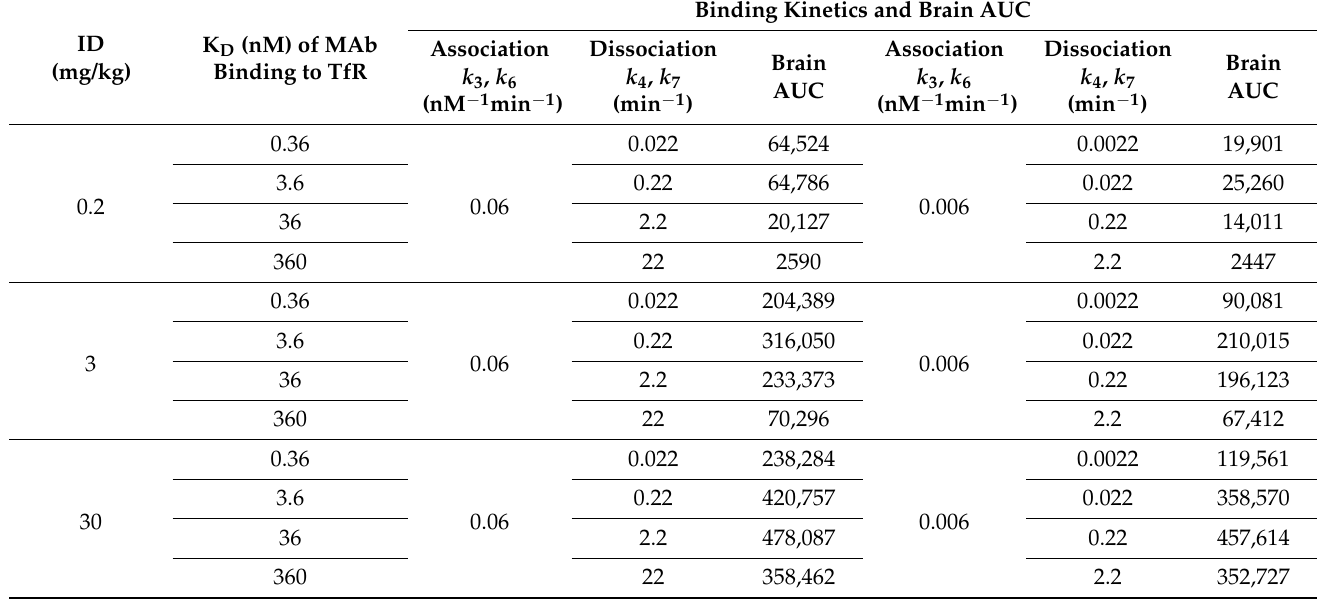
Table 4. TfRMAb K D , binding kinetics, and brain TfRMAb